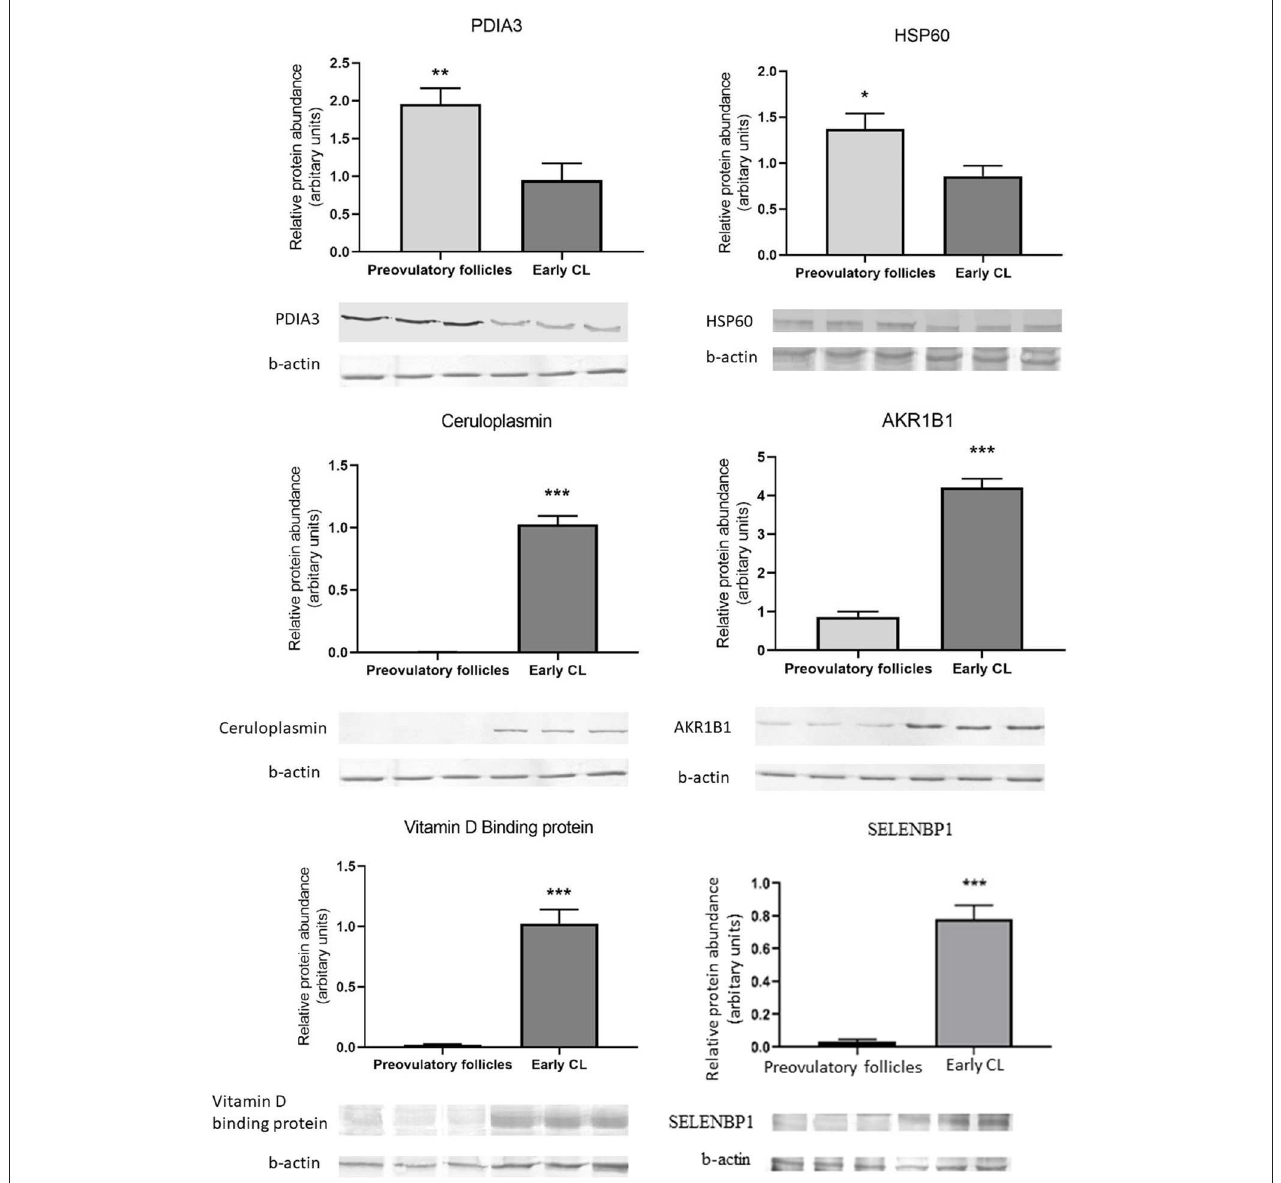
FIGURE 5 | Western blot validation of change in abundances of proteins associated with unfolded protein resonse-PDIA3 and HSP60; oxidative stress response-Ceruloplasmin and AKR1B1; cell proliferation and migration-SELENBP1 and sterol transport-VDBP in newly formed CL as compared to preovulatory follicles. Data are presented as mean ± standard error. * P ≤ 0.05, ** P ≤ 0.01,*** P ≤ 0.001 by t